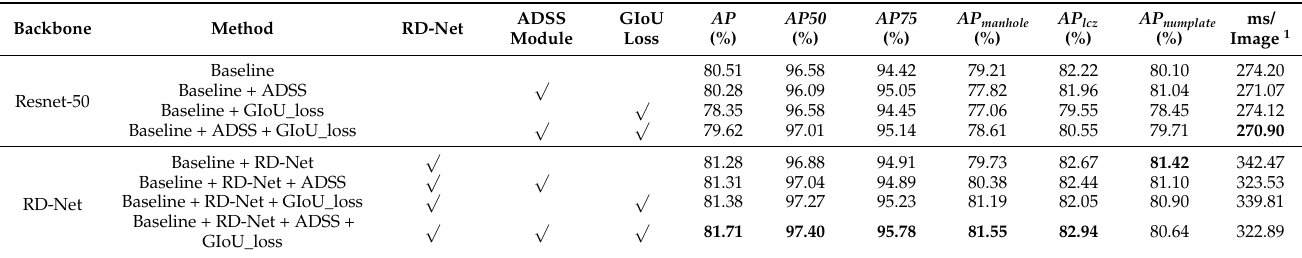
Table 2. Ablation study of the proposed method on the UED